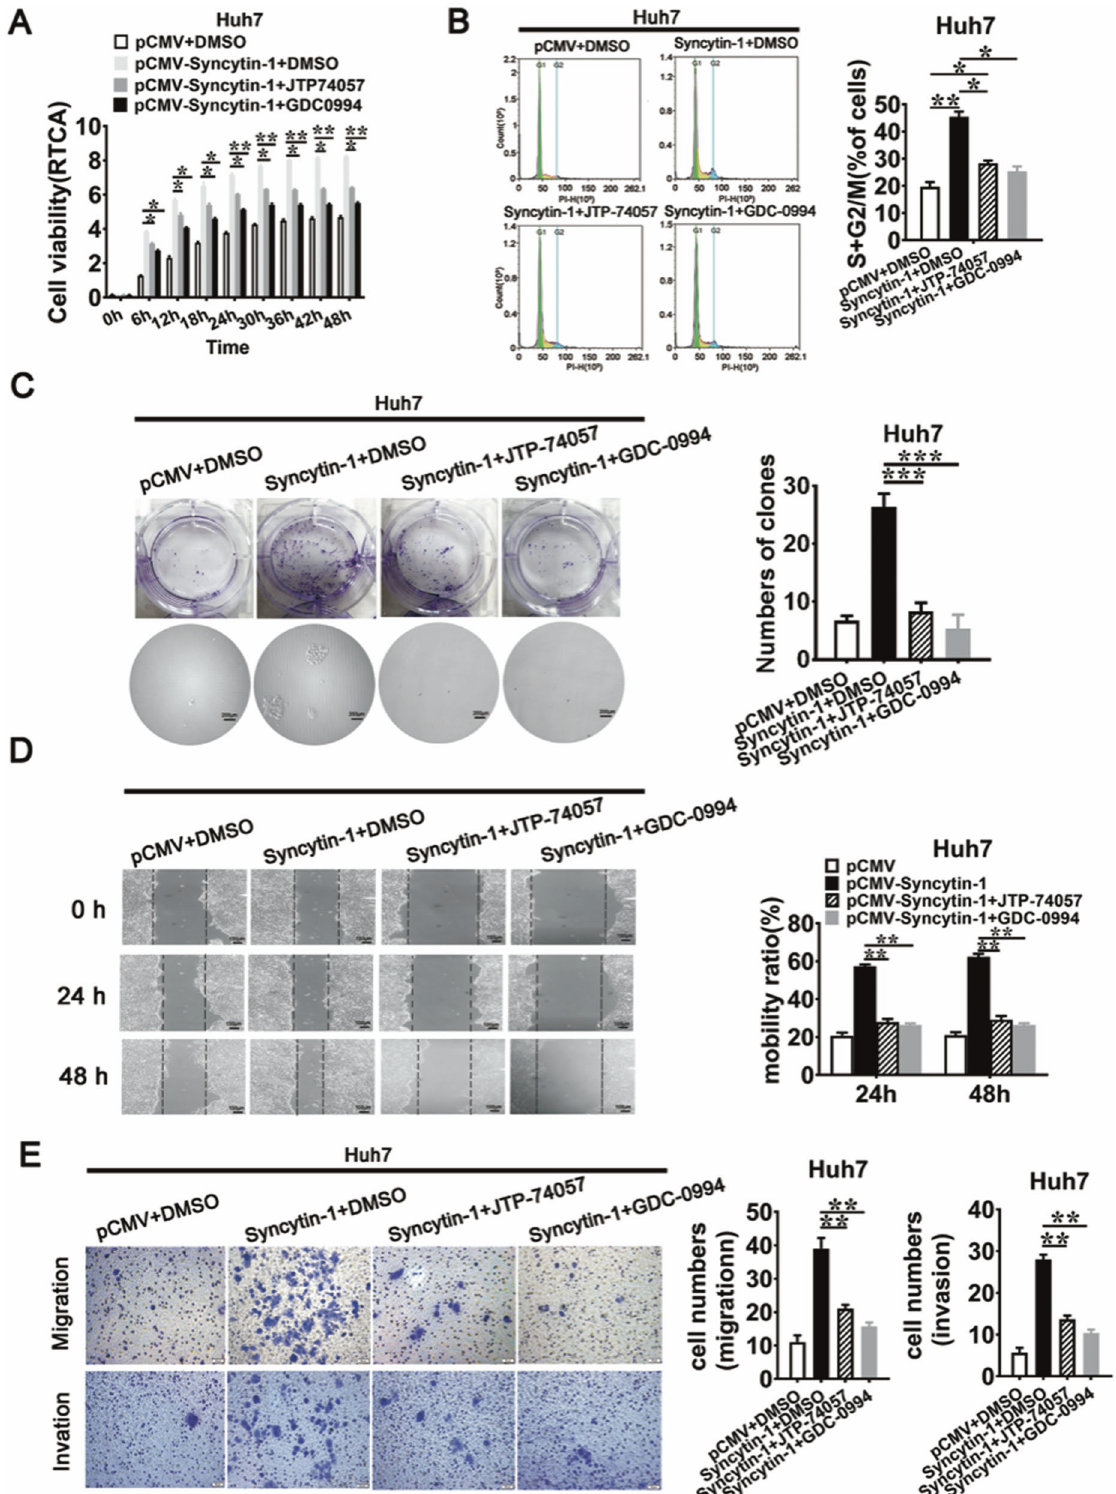
Fig. 5 MEK/ERK signal pathway is necessary for Syncytin-1 induced malignant properties in HCC cells. Huh7 cells transfected with Syncytin-1 were treated with JTP-74057 or GDC-0994, which were speci fi c for MEK/ERK pathway inhibitors. a RTCA assay was used to detect the role of Syncytin-1 on cell proliferation when blocking MEK/ERK pathway. b Flow cytometry. MEK/ERK signal pathway regulation of Syncytin-1-induced cell cycle progression was demonstrated. c The effect of the MEK/ERK pathway on Syncytin-1-induced cell transformation was determined. d and e The role of the MEK/ERK pathway on Syncytin-1-regulated cell migration or invasion was investigated using wound healing assay ( d ), transwell migration assay, and transwell invasion assay ( e ). All graphs show at least three independent experiments. * p < 0.05, ** p < 0.01, *** p < 0.001.